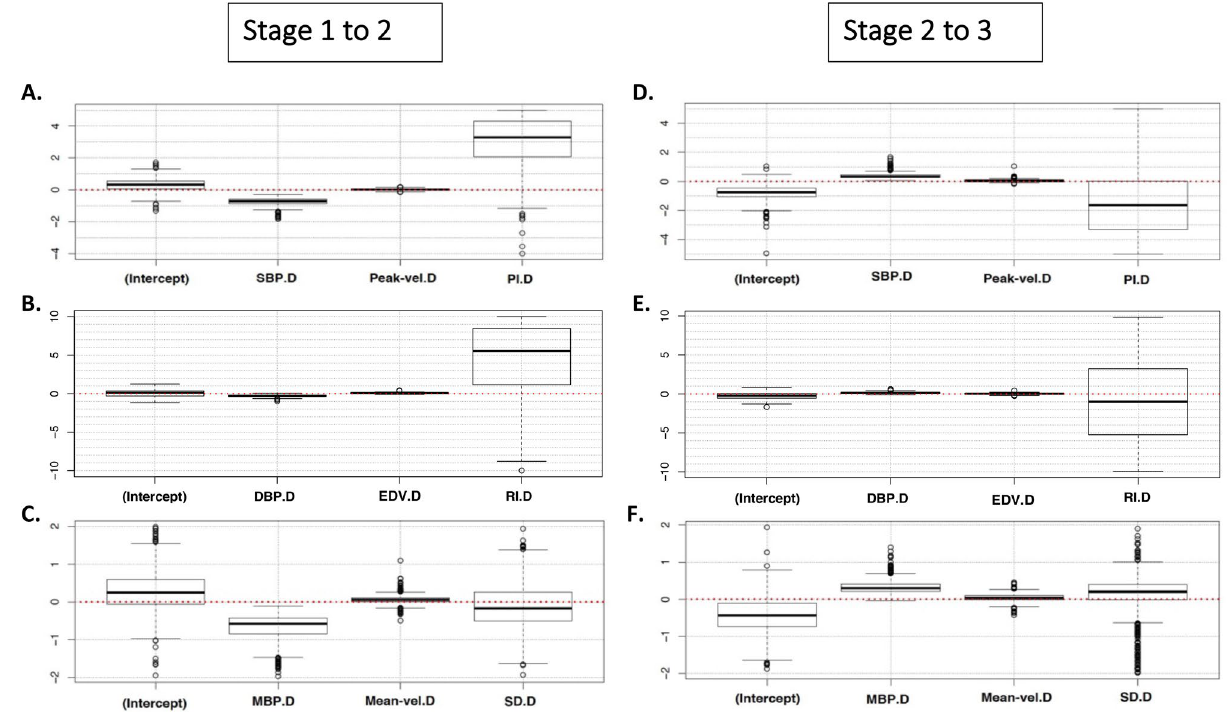
Figure 4. Boxplots of the variation of the coefficients obtained with bootstrap (with 1,000 iterations) with three groups of variables. Stage 1 to 2: From rest to test; in the change from stage 1 (of rest) to stage 2 (of test) Stage 2 to 3. From test to rest; in the change from stage 2 (of test) to 3 (of rest). SBP systolic blood pressure, DBP diastolic blood pressure, MBP mean blood pressure, Peak-vel . systolic velocity of the MCA, Mean-vel . mean velocity of MCA, EDV end diastolic velocity of the MCA, PI pulsatility index, RI resistance index, SD systolic/ diastolic velocity